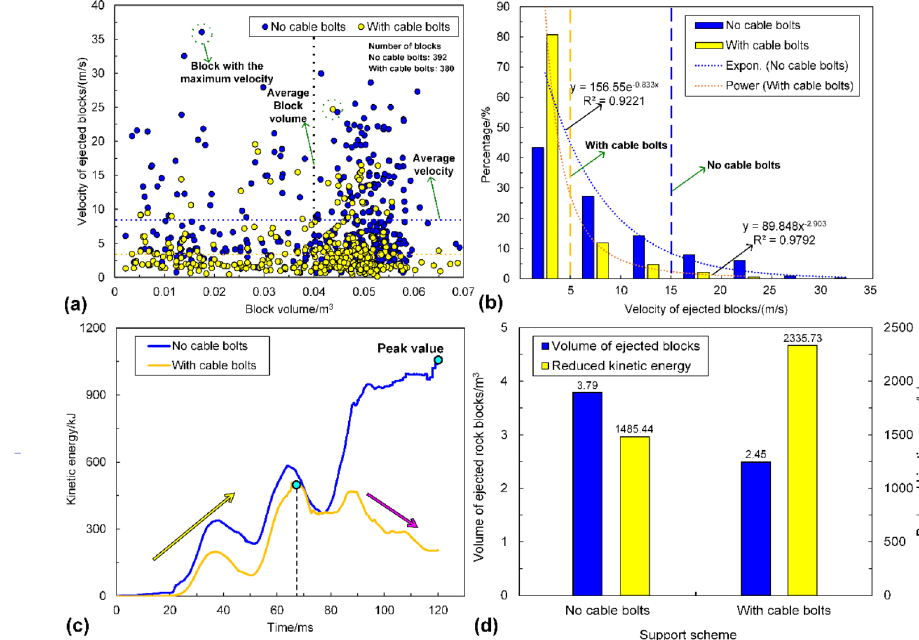
Fig. 26 a is the velocity of all detached blocks versus block volume; b is the velocity distribu- tion of all detached blocks; c is the evolution of the kinetic energy of ejected rock blocks in the tunnel; d is the comparison of the volume of ejected rock blocks and reduced kinetic energy